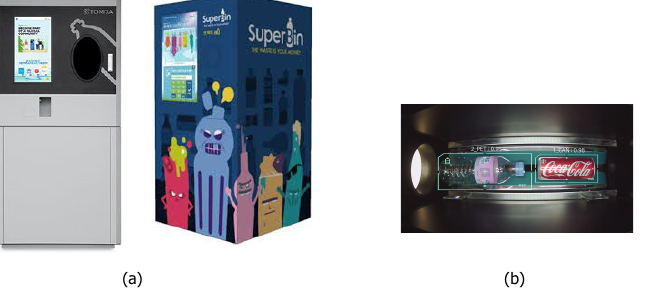
Figure 3. Commercial reverse vending machines (RVM). ( a ) The RVM from TOMRA and Superbin. ( b ) View from inside the RVM. Images are taken from TOMRA and Superbin’s official websites (https://www.tomra.com, accessed on 23 February 2021, http://superbin.co.kr, accessed on 23 Febru- ary